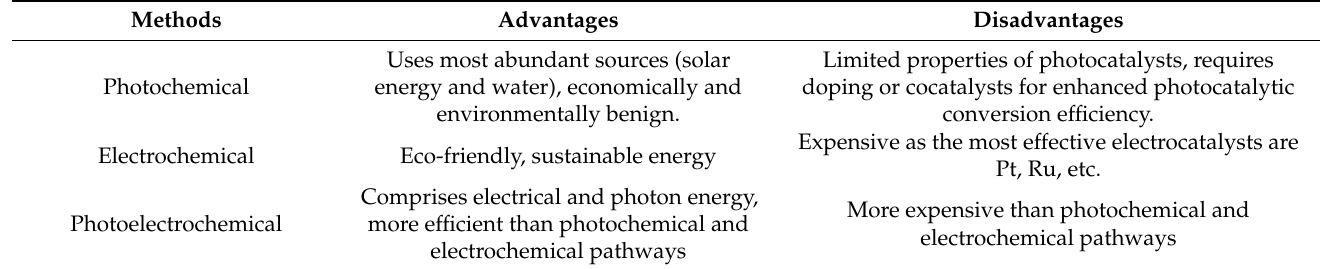
Table 1. Advantages and disadvantages of photochemical, electrochemical and photoelectrochemi- cal methods. Methods Advantages Disadvantages